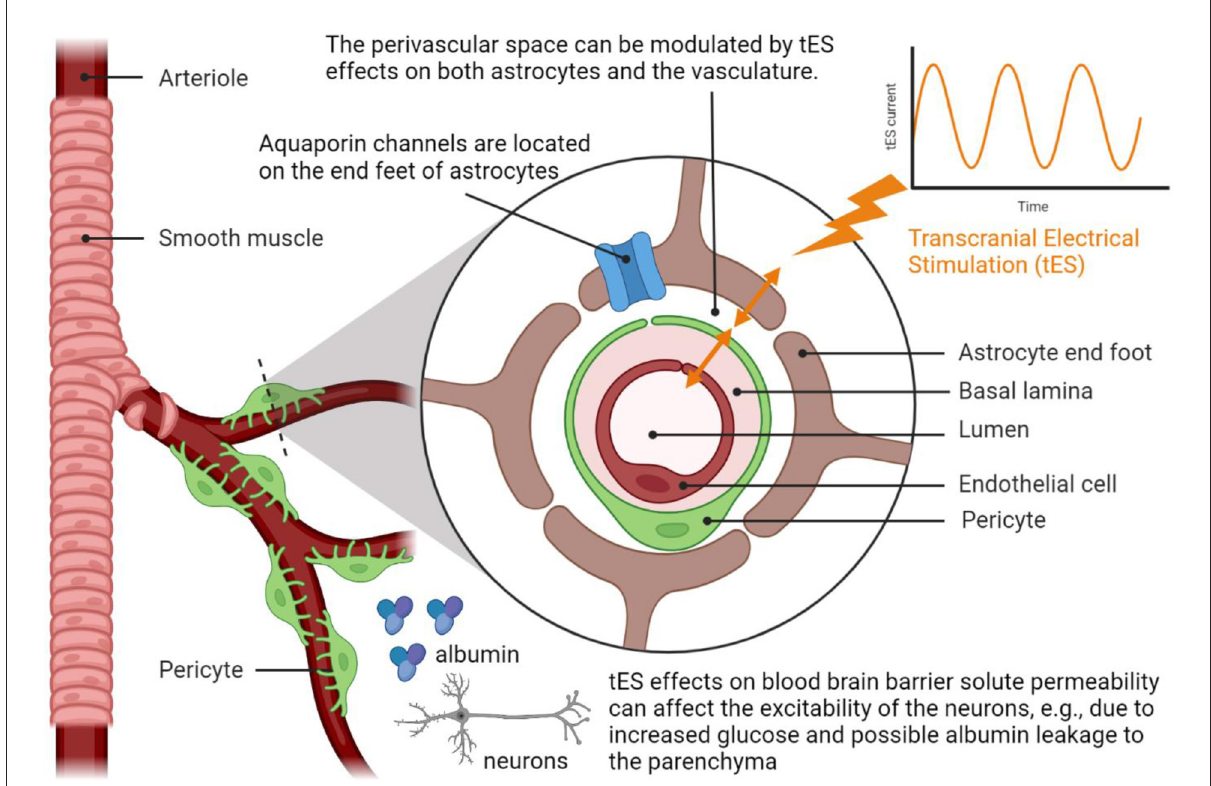
FIGURE3 Transcranial electrical stimulation can acutely modulate perivascular space morphology by affecting the interactions between the astrocyte end feet that cover smooth muscle cells and endothelial cell walls, i.e., the perivascular pathway elucidated by Arora et al. (1). Neuroimaging evidence of the modulation of the perivascular space morphology from Minager et al. (36). Created with